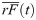
Association traces of biotin-DNAds*Fl binding to SAV and AV.The rF¯(t) and F¯(t) signals of the association reactions of B7-DNAds*Fl (20nM) to (A) AV (520 nM) and (B) SAV (200 nM), at 15°C. (C) Concentration dependence of B7-DNAds*Fl (20 nM) binding to AV at 15°C. All curves (black line) were strongly biphasic. Notice the inversion of SF signals. However, the F¯(t) traces were in prefect agreement with QY experiments (Table 4).